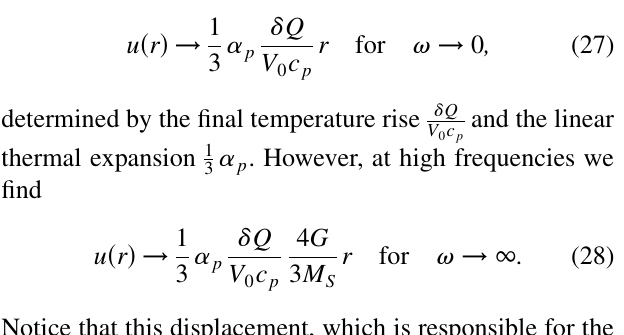
Þ ¼ = ð 1 (cid:2) a l l